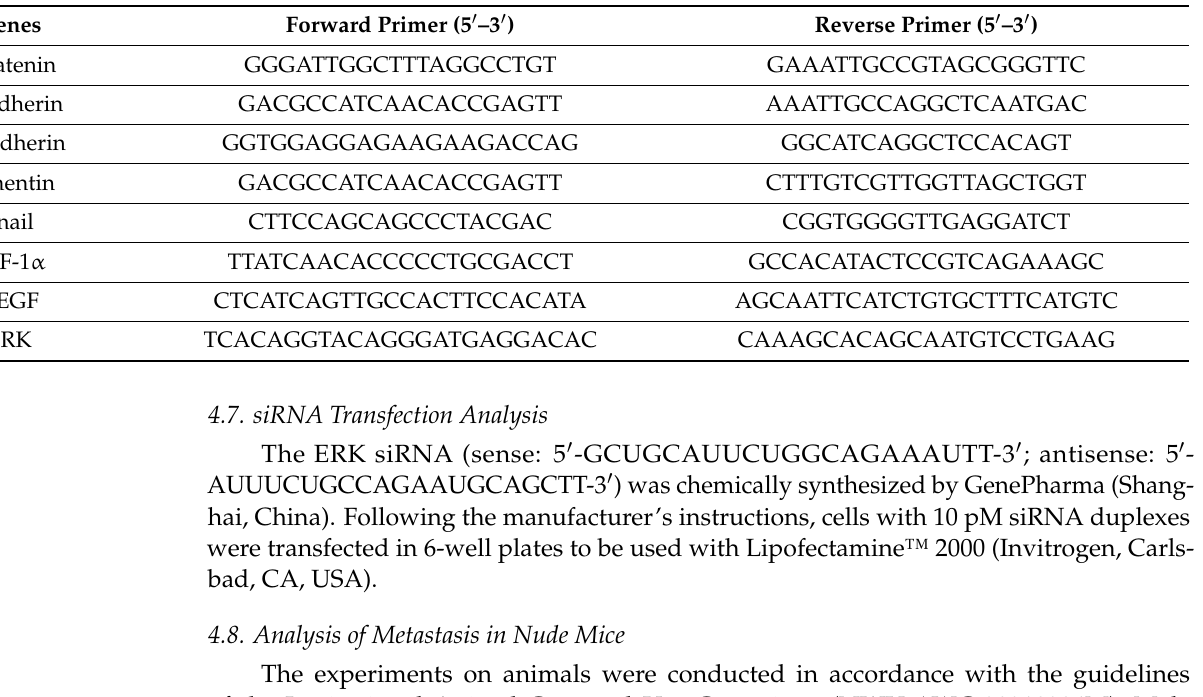
Table 1. Sequences of primers used in